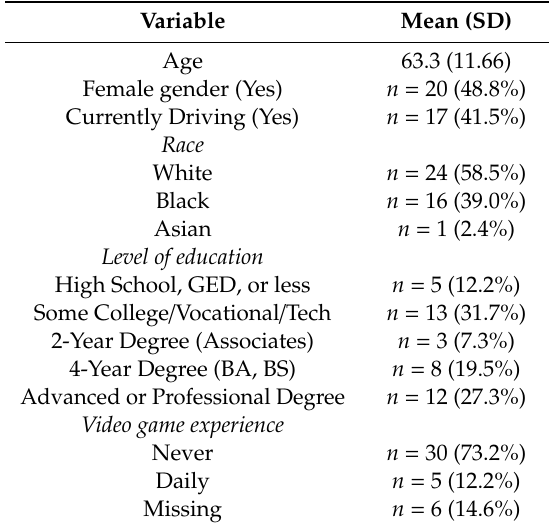
Table 2. Demographic characteristics of the study sample.